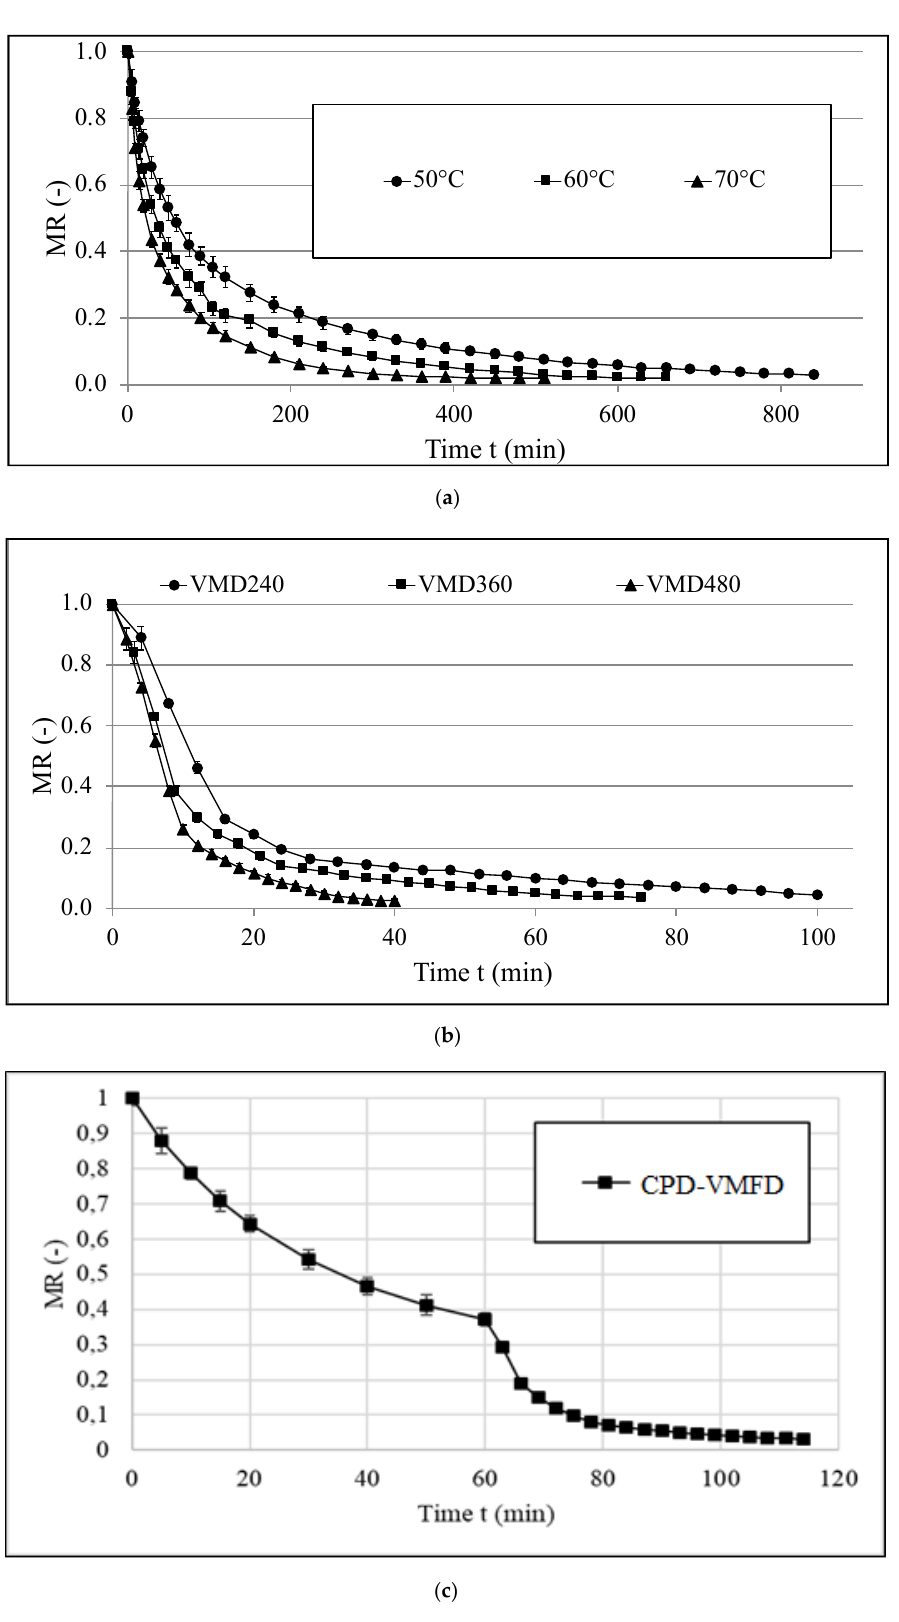
Figure 1. Drying kinetics of hemp flowers treated by convective drying (CD) at 50, 60, and 70 °C ( a ); vacuum–microwave drying (VMD) at 240, 360, and 480 W ( b ); and combined drying consisting of convective pre-drying (CPD) at 60 °C for 1 h and following vacuum–microwave finishing drying (VMFD) at 360 W ( c ).